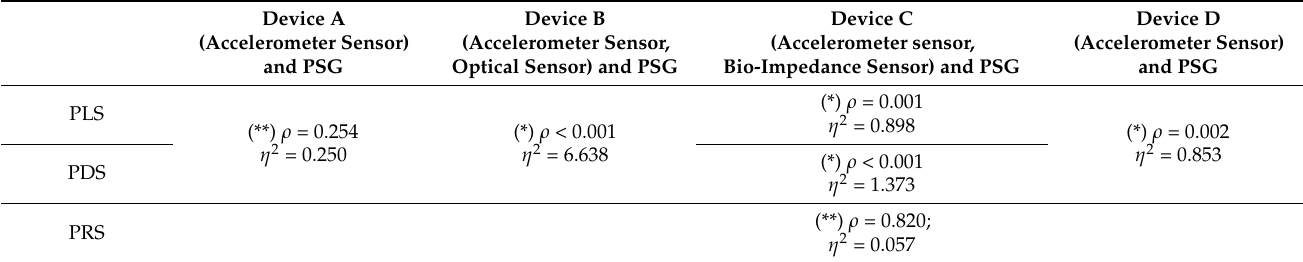
Table 6. Statistical comparison of Light, Deep, and REM stages among four sleep tracker devices.